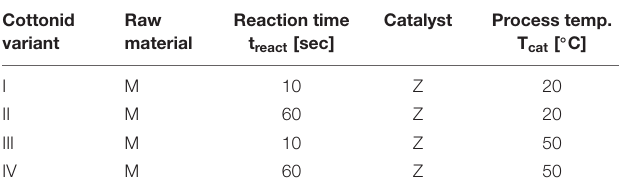
TABLE 1 | Sample designation of the produced Cottonid variants. Cottonid